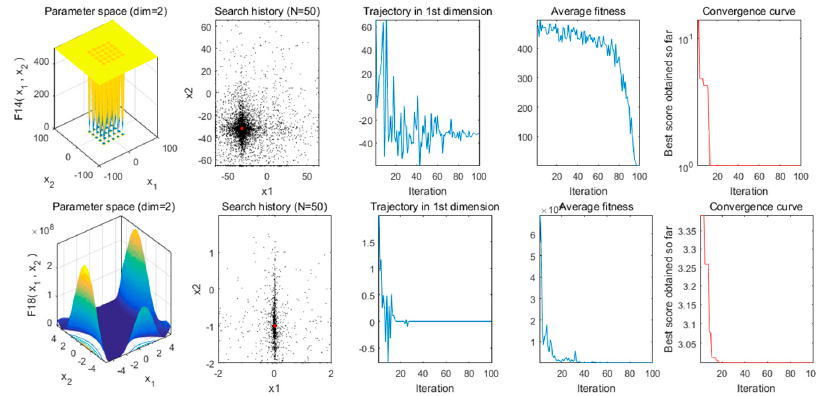
Figure 3. Search history and track of the first particle in the first dimension (part).